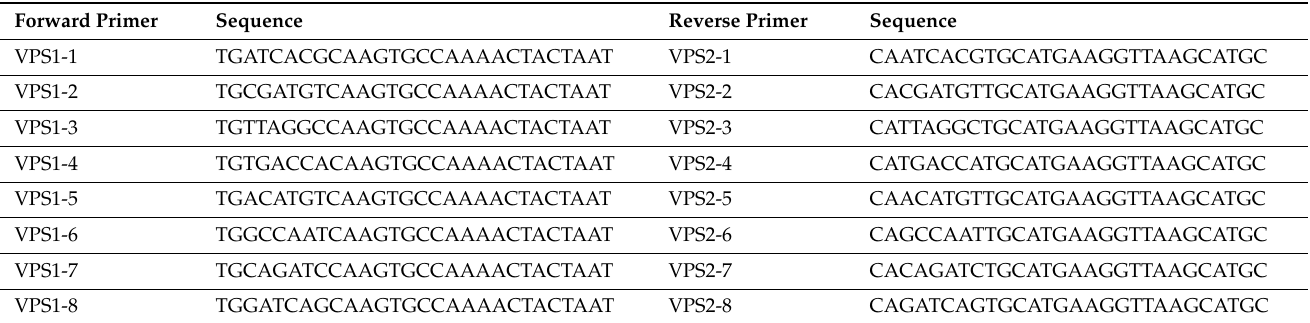
Table 1. Barcoded primers for VP1